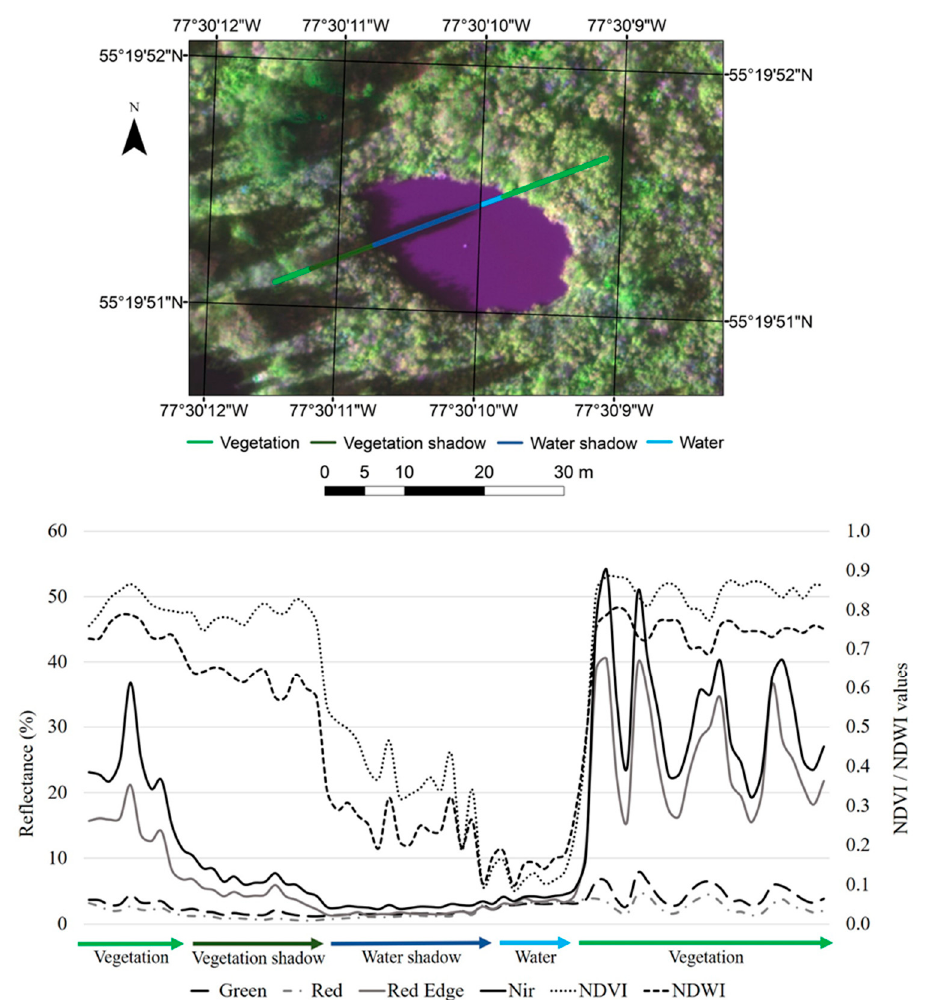
Figure 5. Reflectance, NDWI and NDVI variation across Pond-52 showing the effects of different surface types.